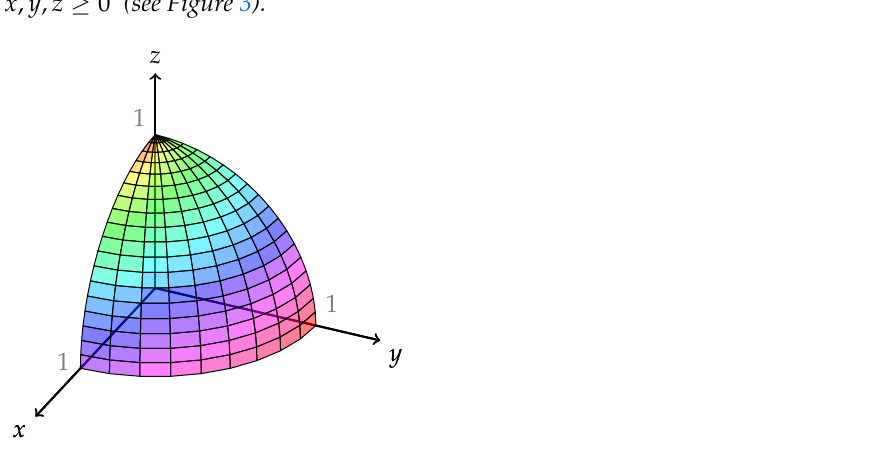
Figure 3. Portion of sphere x 2 + y 2 + z 2 ≤ 1 in the first octant x , y , z ≥